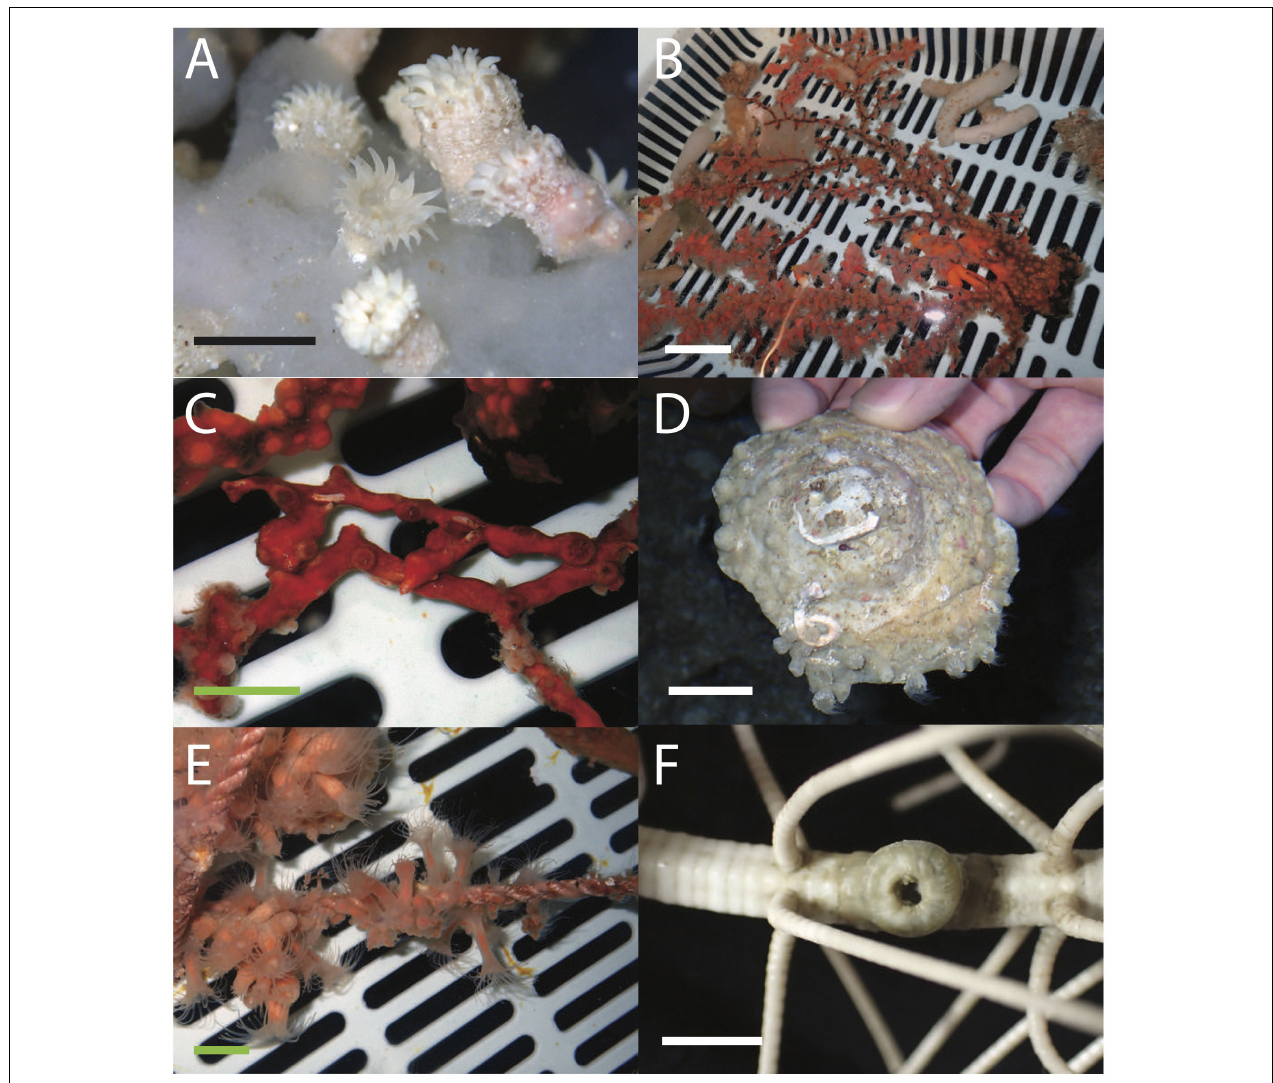
FIGURE 2 | Images of living zoantharian specimens collected from Japan phylogenetically examined in this study. (A) Parazoanthidae sp. 1 MISE-MZ1 on glass sponge, (B) Savalia sp. 1 MISE-MZ4 on a dead gorgonian or antipatharian, (C) Umimayanthus sp. 1 MISE-MZ5 on an encrusting sponge, (D) Epizoanthus sp. 1 MISE-MZ8 on an empty mollusk shell, (E) Epizoanthus sp. 2 MISE-MZ7 growing on rope, and (F) preserved Abyssoanthidae sp. 1 MISE-Kochi1 on the arm of a crinoid. Scale bars: A, F = approximately 1 cm; B = approximately 5 cm; C, D, E = approximately 2